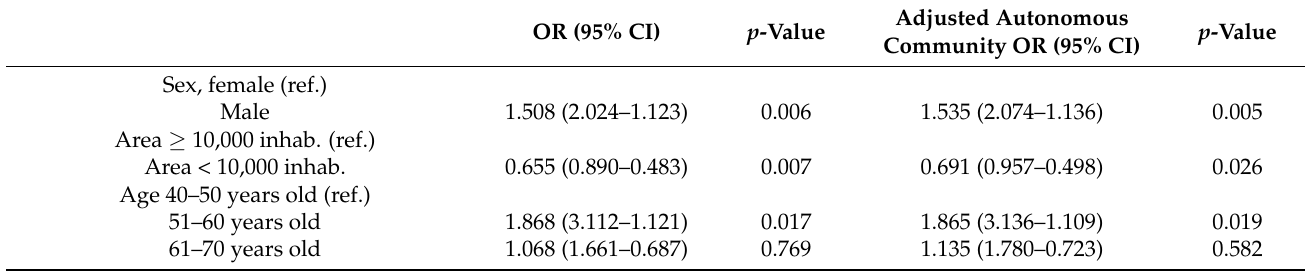
Table 4. Factors associated with the use of spirometry among subjects with respiratory symptoms who visit a doctor. Multivariate analysis. Adjusted Autonomous p -Value OR (95% CI) p -Value Community OR (95% CI) Sex, female (ref.) Male 1.508 (2.024–1.123) 0.006 0.005 Area ≥ 10,000 inhab.